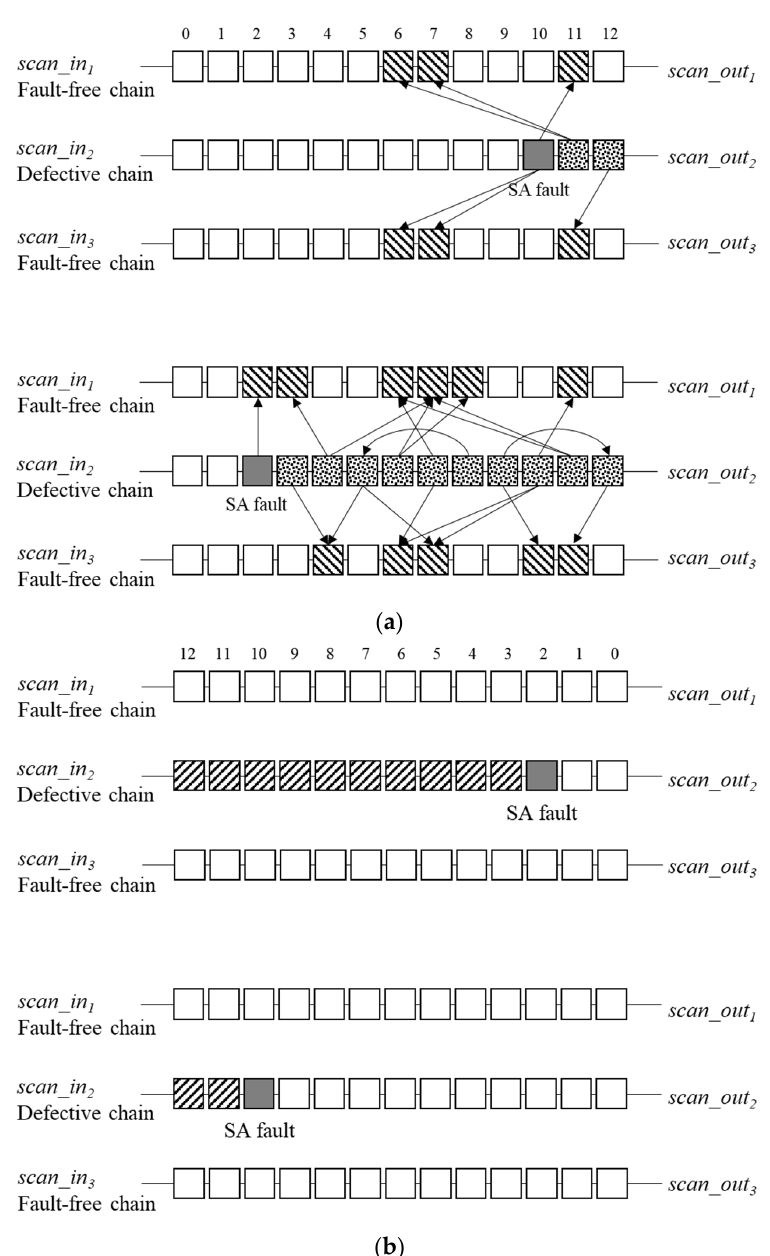
Figure 5. Failure tendencies: ( a ) failure tendency caused by shift ‐ in; ( b ) failure tendency caused by Figure 5. Failuretendencies: ( a )failuretendencycausedbyshift-in; ( b shift ‐ out.